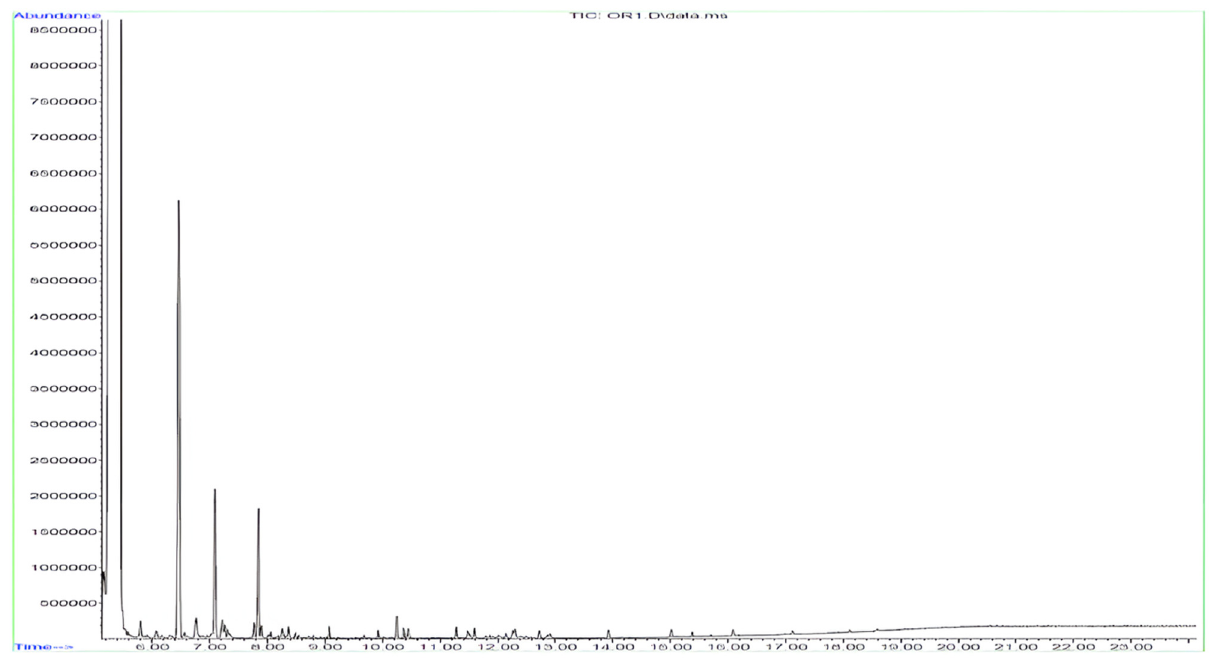
Figure 1: GC – MS chromatographic pro fi le of O. compactum EO.